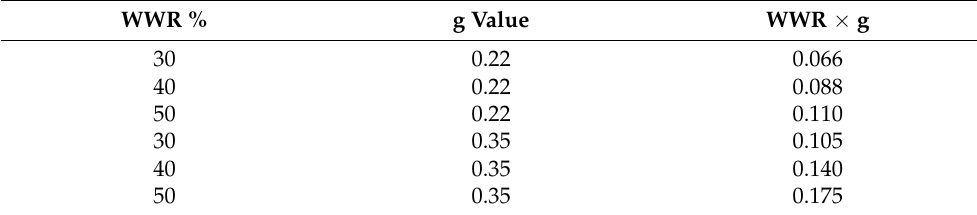
Table 3. Combinations of window wall ratio (WWR) and solar heat gain coefficient (g). WWR % g Value WWR ×